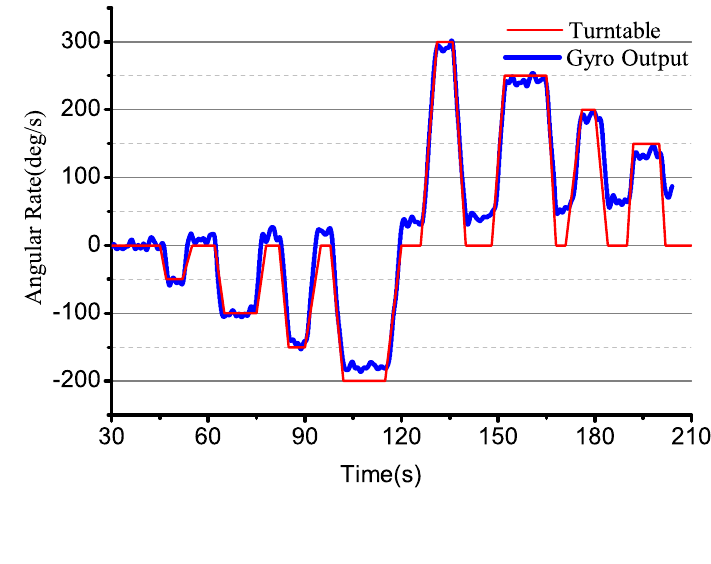
Figure 26. The output of the bell-shaped vibratory angular rate